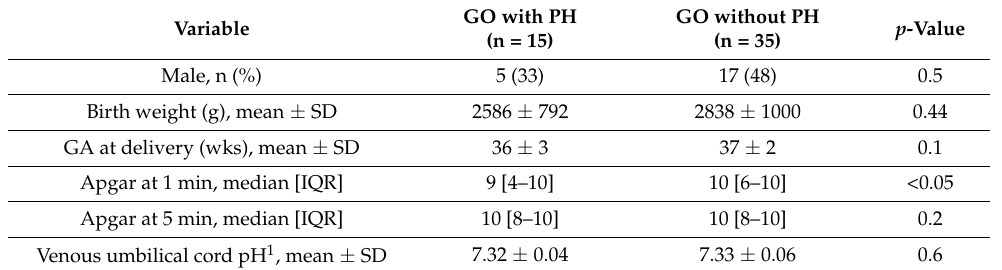
Table 2. Neonatal